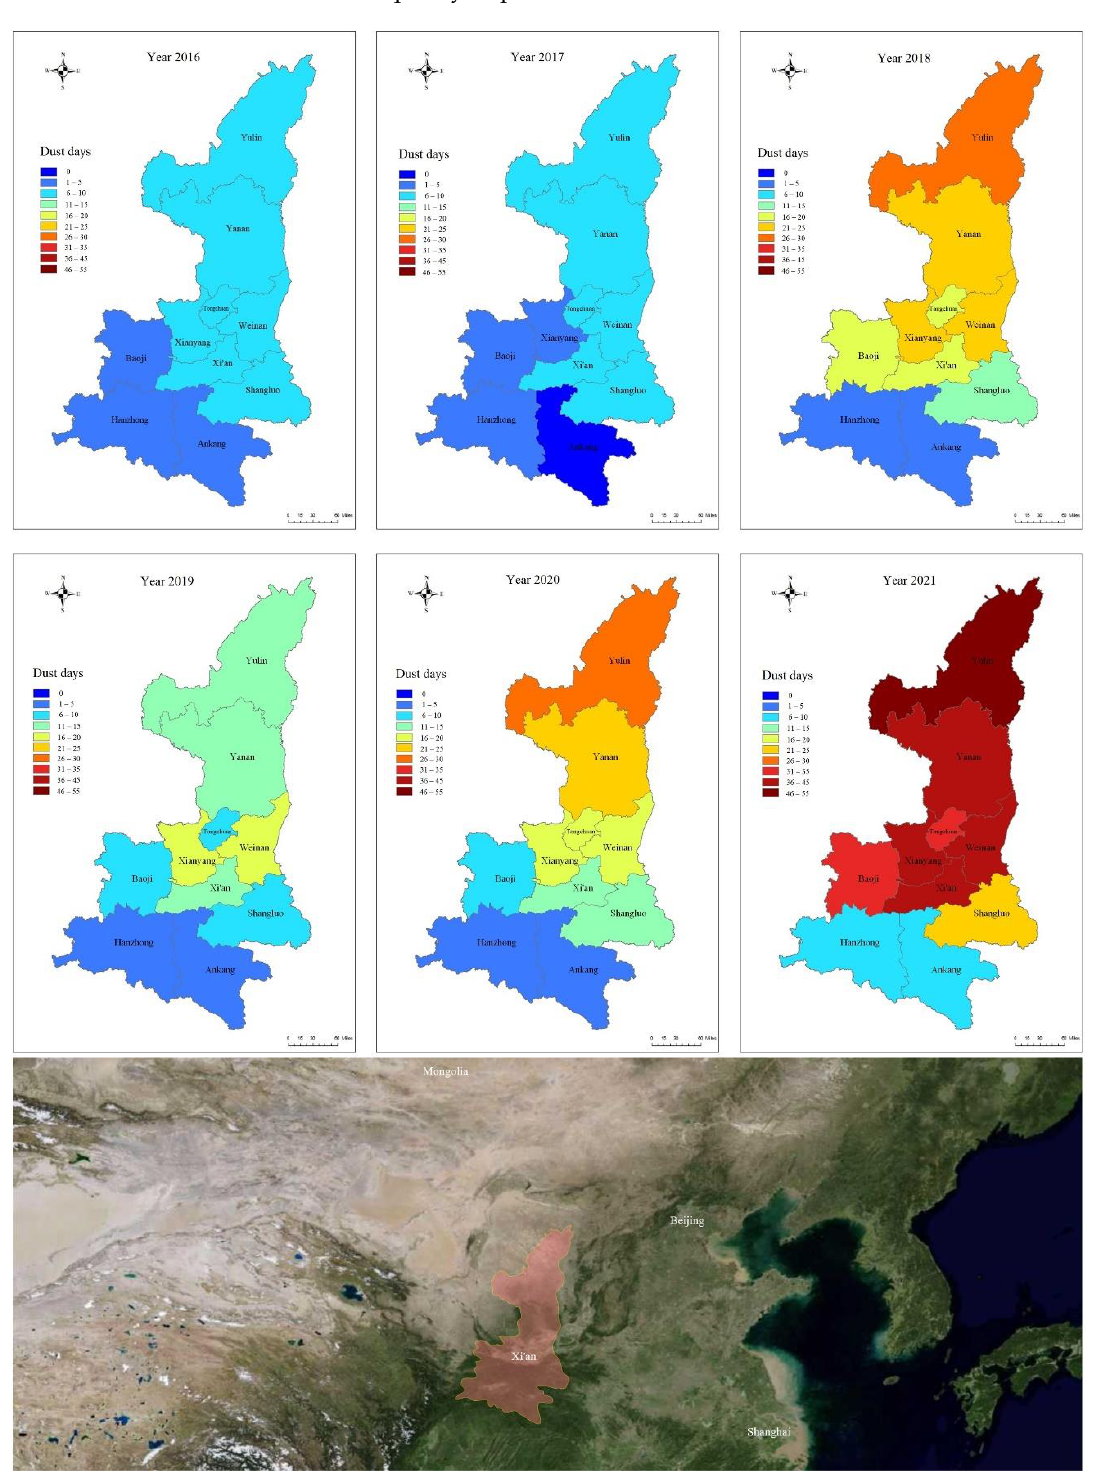
Figure 7. Sand affected days in Shaanxi Province from 2016 to 2021. From the analysis of topography and transmission path, the sand and dust in the northwest originate from the Hexi Corridor in Gansu and enter the Guanzhong Plain from west to east through Tianshui – Baoji. At the same time, affected by the return of sand and dust in the east, sand and dust remain in Guanzhong and accumulate, causing secondary pollution to the city of Guanzhong, showing the characteristics of intermittent occurrence and decreasing intensity of sand and dust for several consecutive days. Originating from